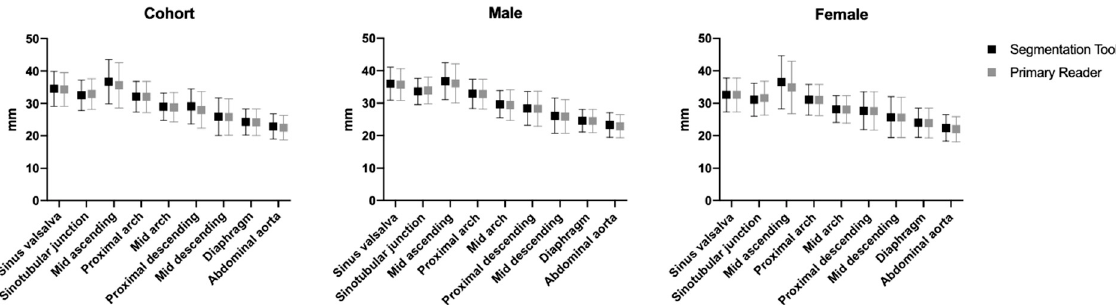
Figure 4. Mean measurements of the segmentation tool and the reader at the respective locations of the thoracic and abdominal supraceliac aorta. Data are presented in mm ± SD.